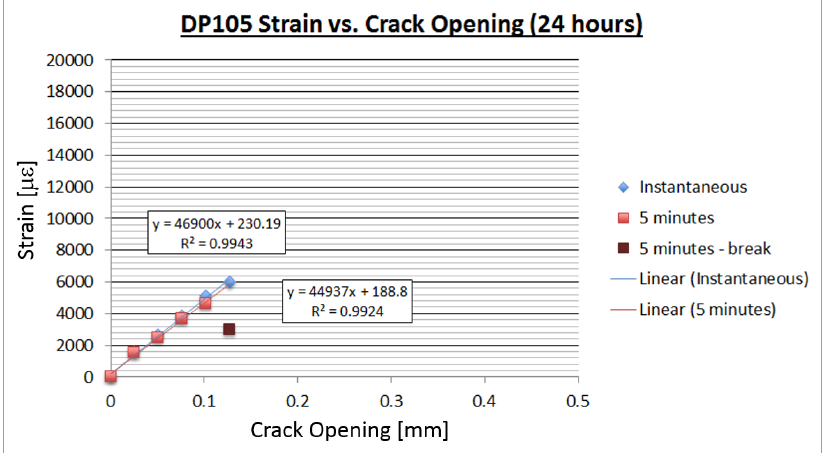
Figure 12. DP105 crack opening vs. strain after 24